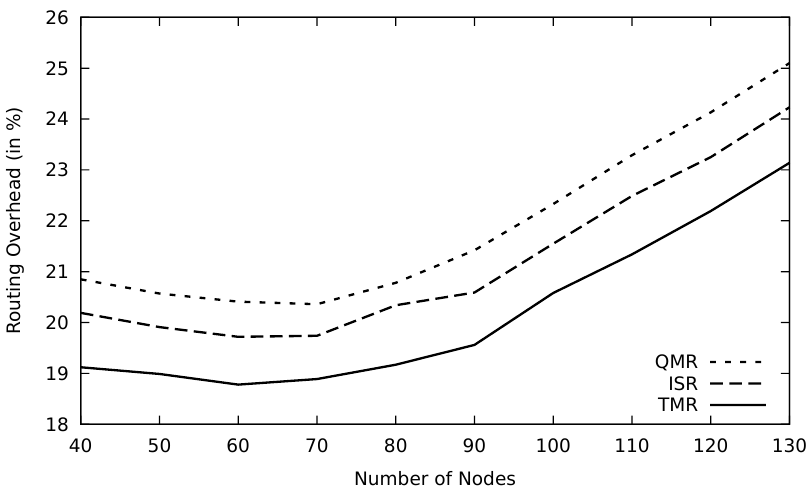
Figure 35. Comparison of QMR, ISR, and proposed protocol TMR for routing overhead with number of